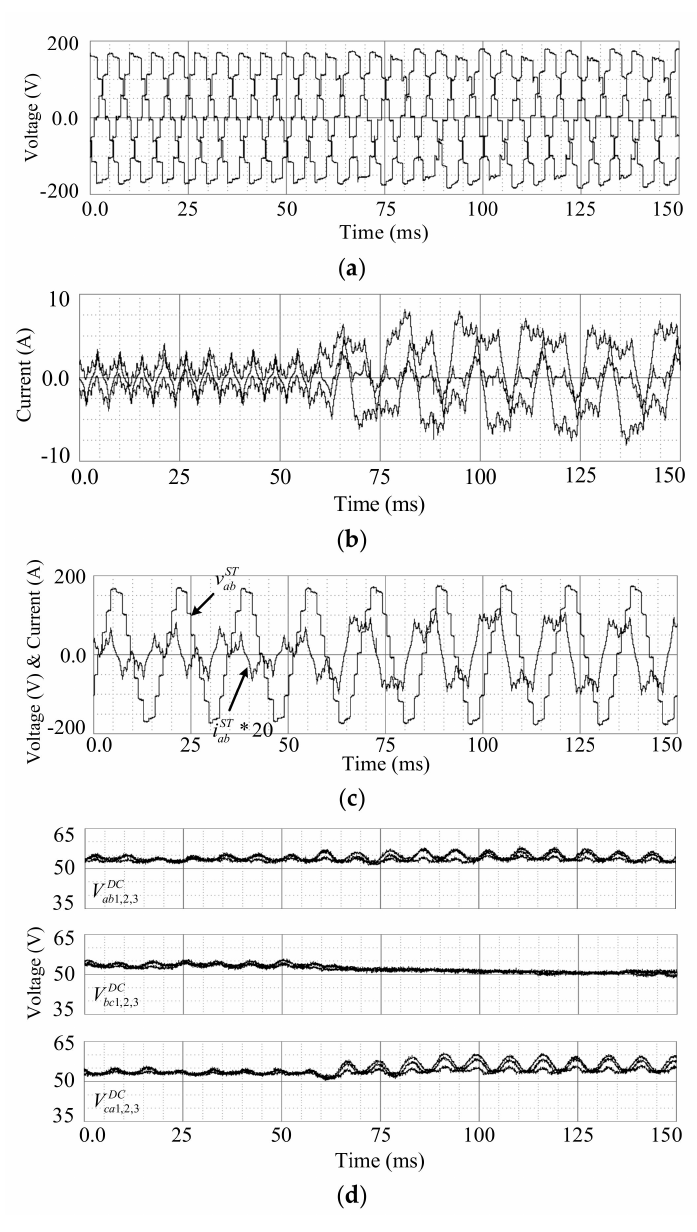
Figure 11. Transient responses of the STATCOM ( a ) Each arm internal voltage ( v ST arm current ( i ST ); ( c ) Arm a-b voltage and current ( v ST ab , bc , ca ( V DC , V DC , V DC ca 1,2,3 ab 1,2,3 bc 1,2,3